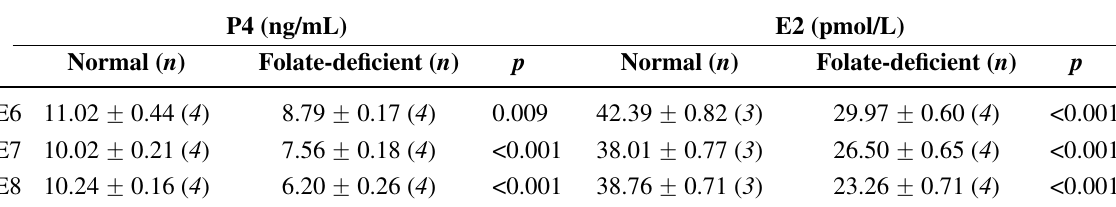
Table 4. Serum P4 and E2 levels in the pregnant mice (mean ± standard error of the mean (SEM)). P4 (ng/mL)